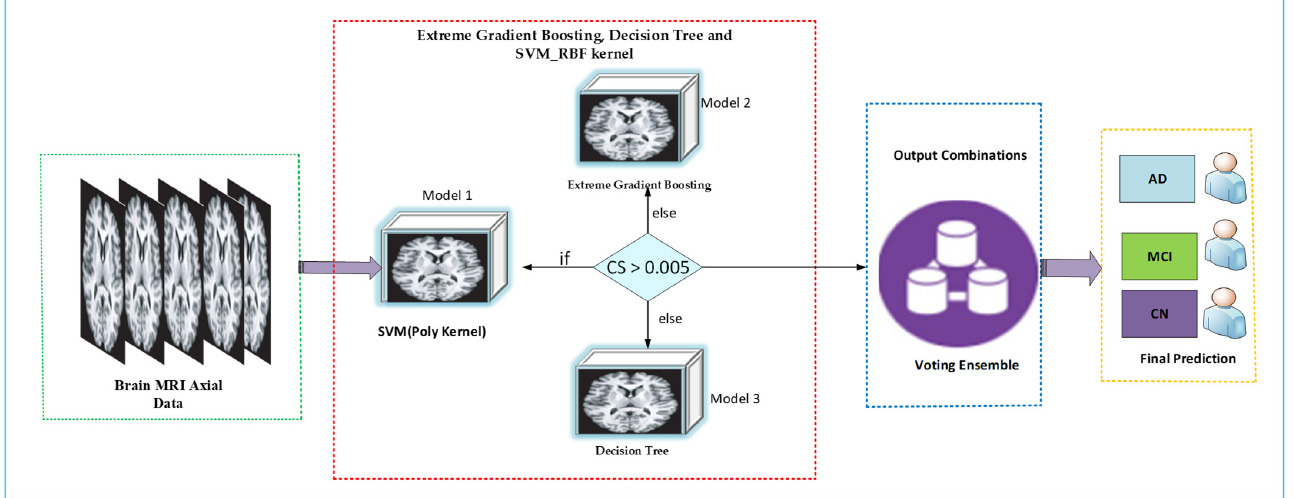
Figure 7. Proposed XGB + DT + SVM Ensemble